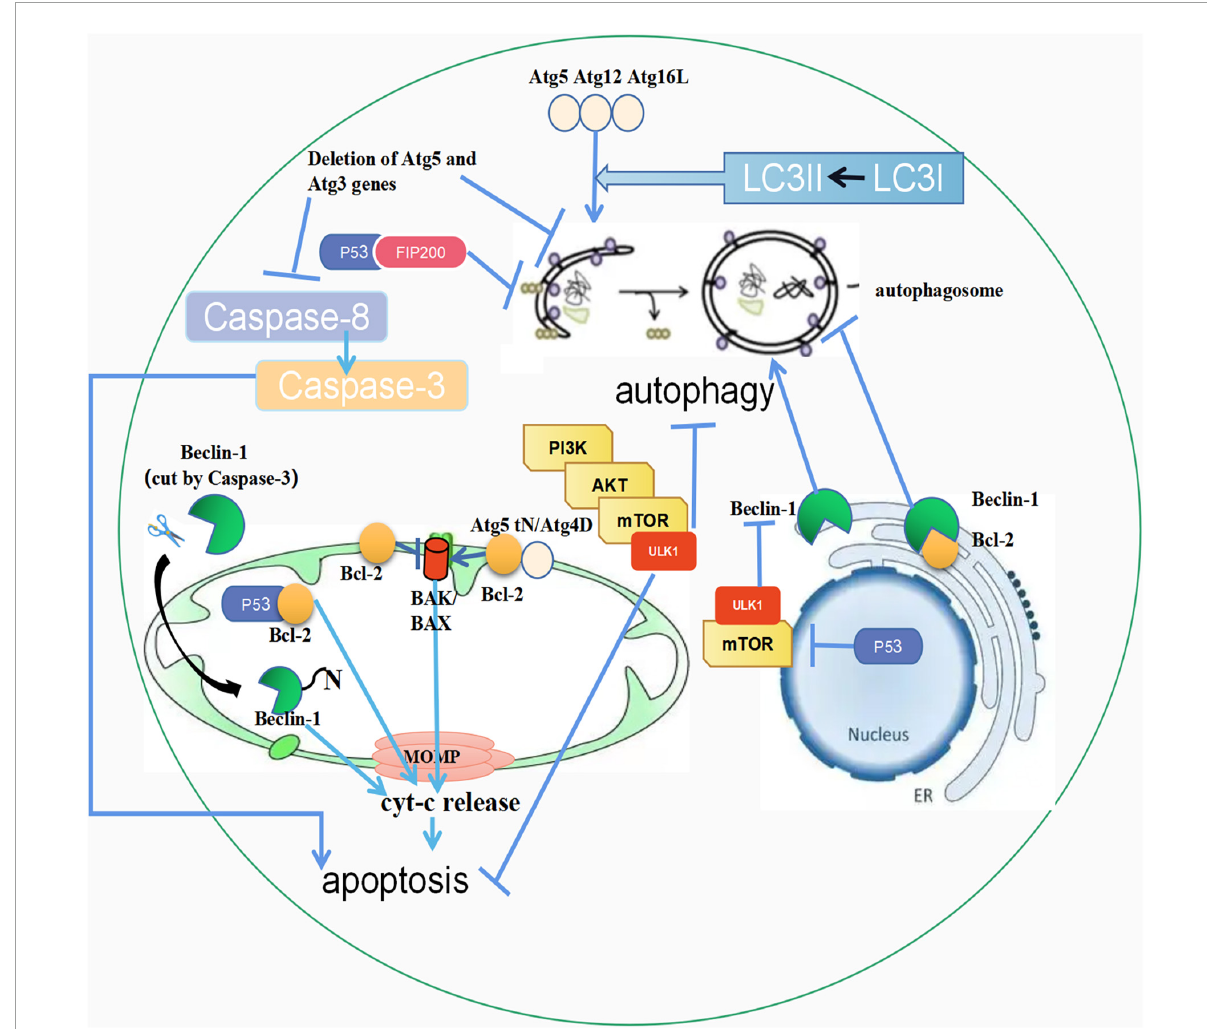
FIGURE1 The crosstalk between autophagy and apoptosis. (1) Atg5, Atg12, and Atg16L combine to form a complex, activating LC3-I to LC3-II. Then LC3-II fuses with the autophagic outer membrane to promote the development of autophagy. In addition, the unconjugated Atg5 is cleaved by calpain, and its product, Atg5tN, naturally enters the mitochondria. Subsequently, in the mitochondria, Atg5tN mediates the release of Cyt-c by interacting with BCL-2 proteins, thereby promoting apoptosis. Full-length Atg4D promotes apoptosis, and (cid:49) N63 Atg4D gains GABARAP-L1 coupling autophagy with apoptosis; (2) The PI3K/AKT/mTOR pathway can inhibit both autophagy and apoptosis; (3) Beclin-1 in the endoplasmic reticulum can promote the occurrence of autophagy, but when combined with Bcl-2, it can inhibit autophagy. The cleaved Beclin-1 by Caspase-3 can be translocated to mitochondria, triggering apoptosis; (4) p53 in mitochondria can combine with Bcl-2 to promote apoptosis. p53 in the nucleus promotes autophagy through the mTOR pathway, and p53 in the cytoplasm inhibits autophagy by interacting with FIP200.